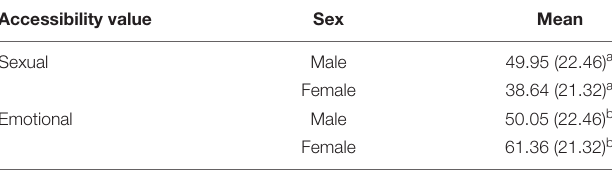
TABLE 2 | Mean perceived importance of accessibility type across sex. Accessibility